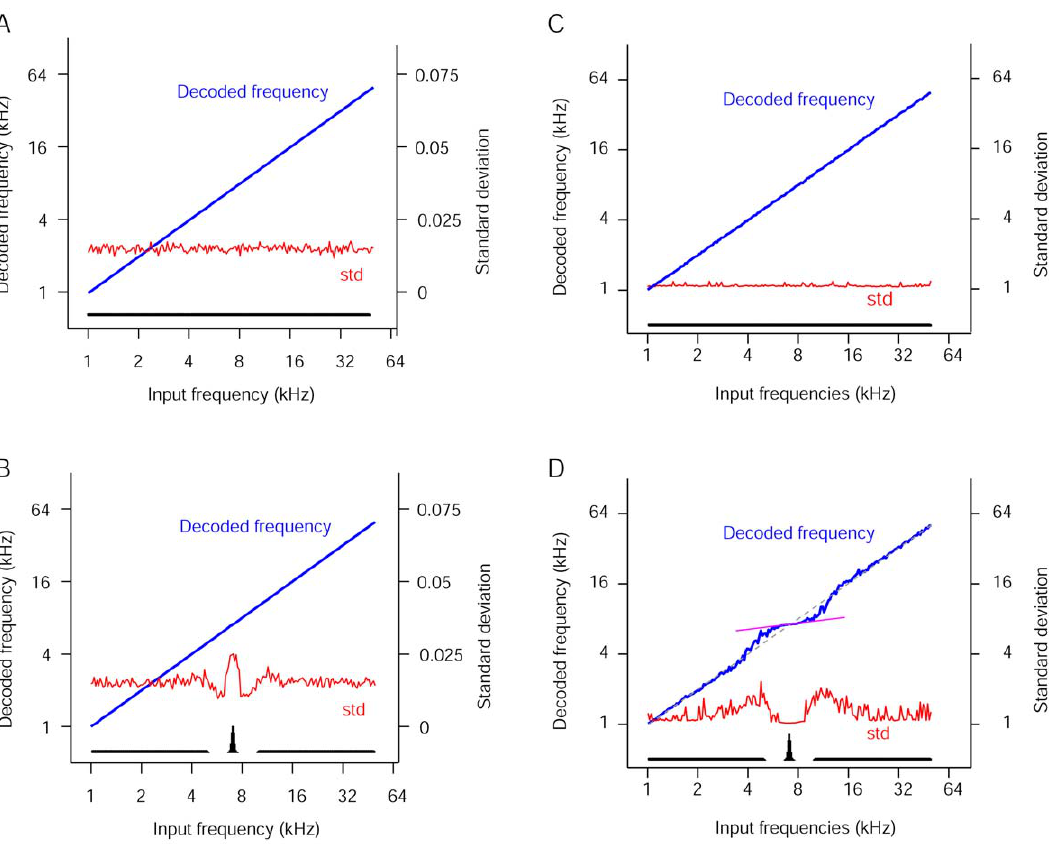
Figure 3. Decoded frequency as a function of input frequency. Both the naı¨ve model AI ( a and c ) and 7-kHz-over-represented AI ( b and d ) were examined with ( c and d ) and without ( a and b ) elevated baseline activity. In addition, standard deviation of the decoded frequencies (red) was used to measure the output variability. When baseline activity was elevated in the 7-kHz-over-represented AI, the decoded frequencies show shifts characteristic of Bayesian prior bias ( d ). The pink line shows the slope of the input-output curve at the over-represented frequency. The slope is a measure of the prior bias.